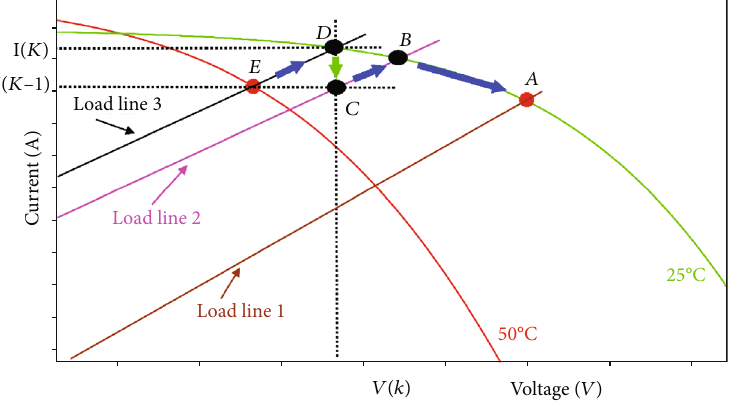
Figure 13: Operating point (OP) movement procedure under sudden decreasing of temperature.